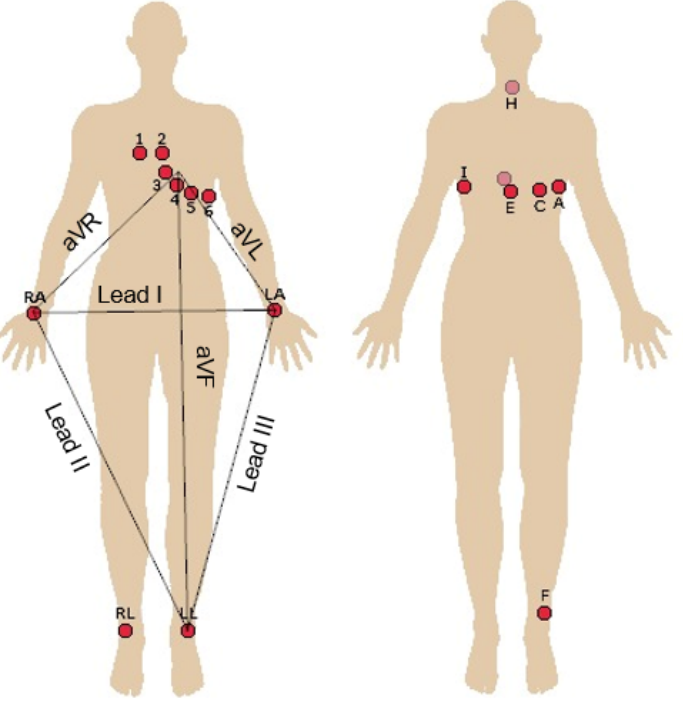
Figure 4. Electrode placement and leads on the standard 12-lead configurations ( left ) and Frank leads ( right ), with the anterior electrodes depicted in red and the posterior electrodes depicted in a lighter red (adapted from [5], original figure kindly provided by the